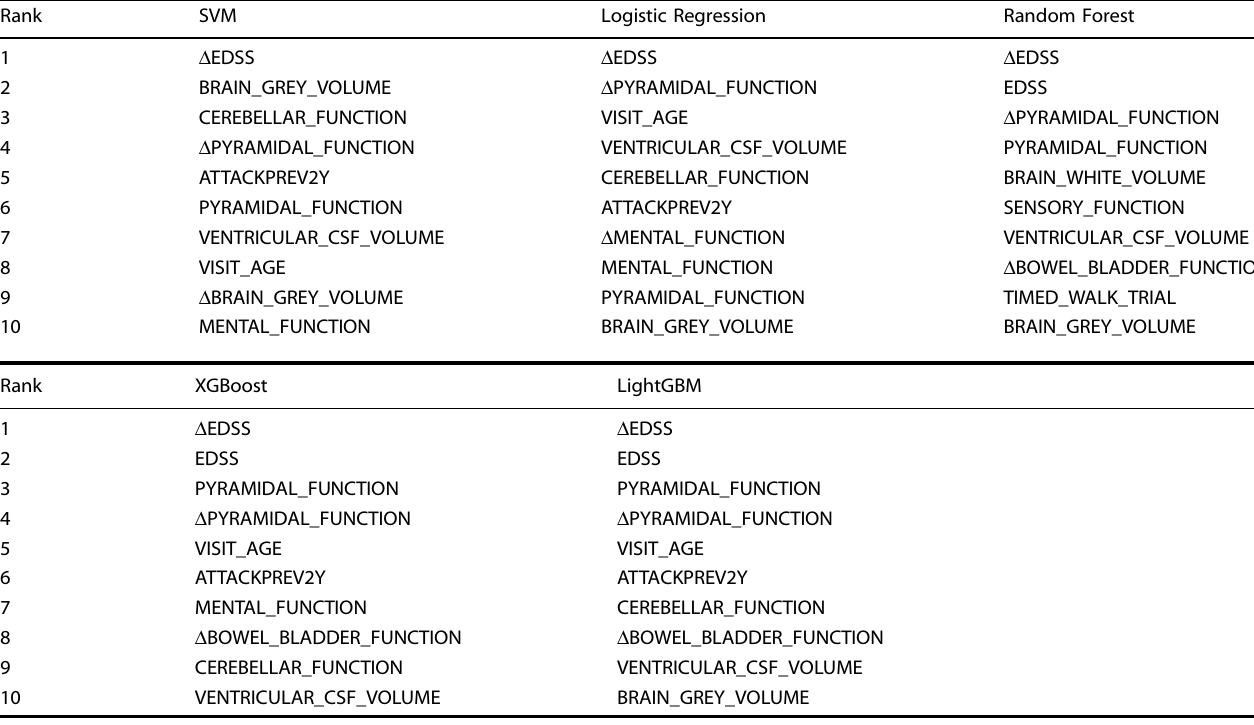
Table 5. Top ten predictive features identi fi ed by fi ve models using the EPIC